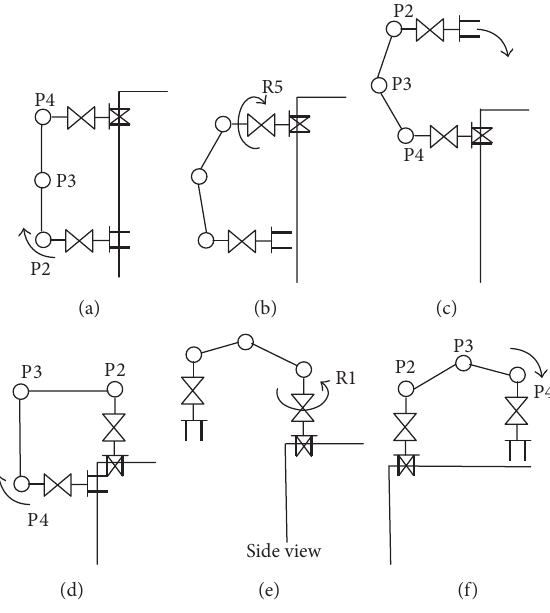
Figure 10: The conventional gait for exterior transition.